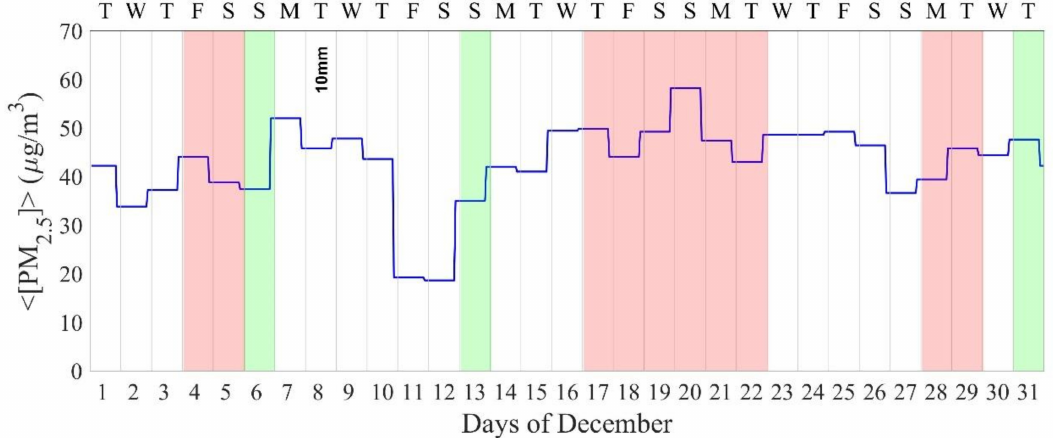
Figure 15. Particulate matter PM 2.5 concentration variation related to the total block of urban traffic (green band) and alternated plates (red band) of December 2015. The blue line is the hourly pollutant concentration. Data of daily precipitation are indicated in